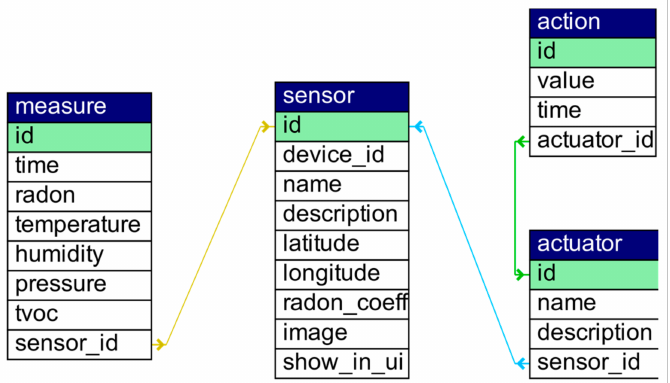
Figure 2. The database schema of the air quality control